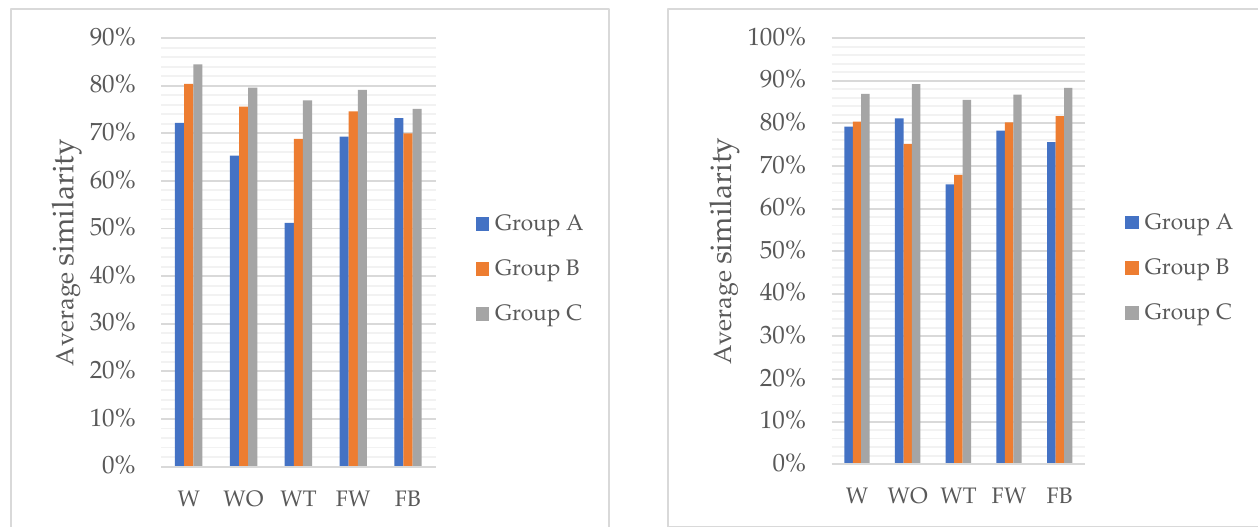
Figure 13. Local action recognition results.